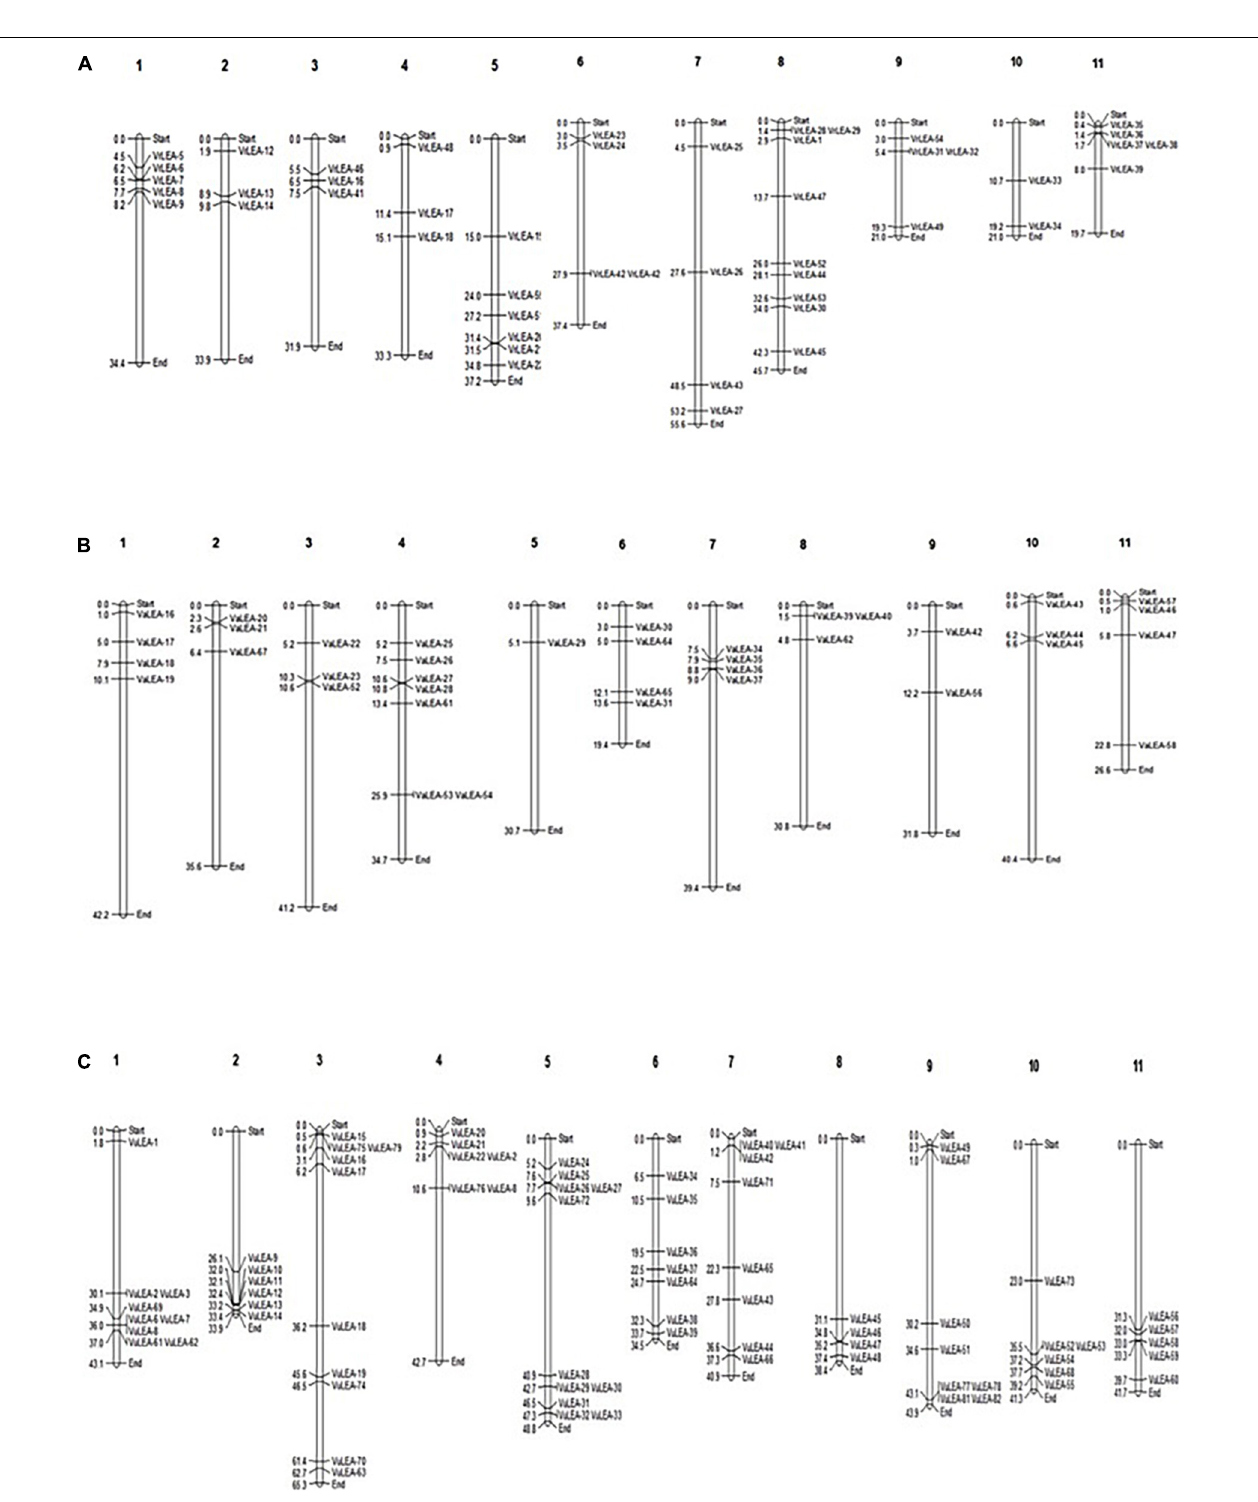
FIGURE 1 | (A) Chromosomal distribution of late embryogenesis abundant ( LEA ) genes on mung bean ( Vigna radiata ) genome. (B) Chromosomal distribution of LEA genes on adzuki bean ( Vigna angularis ) genome. (C) Chromosomal distribution of LEA genes on cowpea ( Vigna unguiculata ) genome.